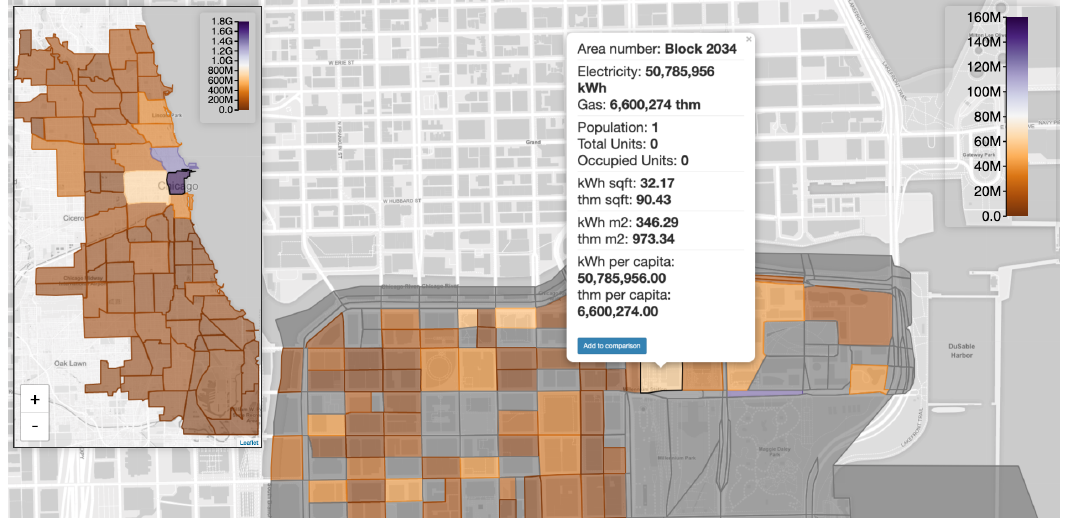
Figure 5. Details on demand in the detail map, showing the one block in the selected neighborhood that has higher energy consumption. Unusually, this downtown block features a single inhabitant, and no occupied